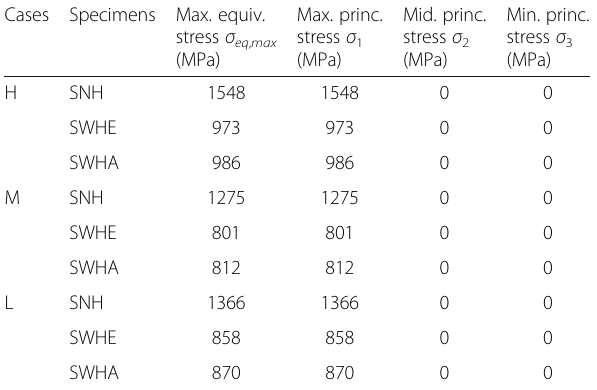
Table 5 Stresses at the reference point of the different specimens after the 2D linear FEA Cases Specimens Max. equiv. stress σ eq , max